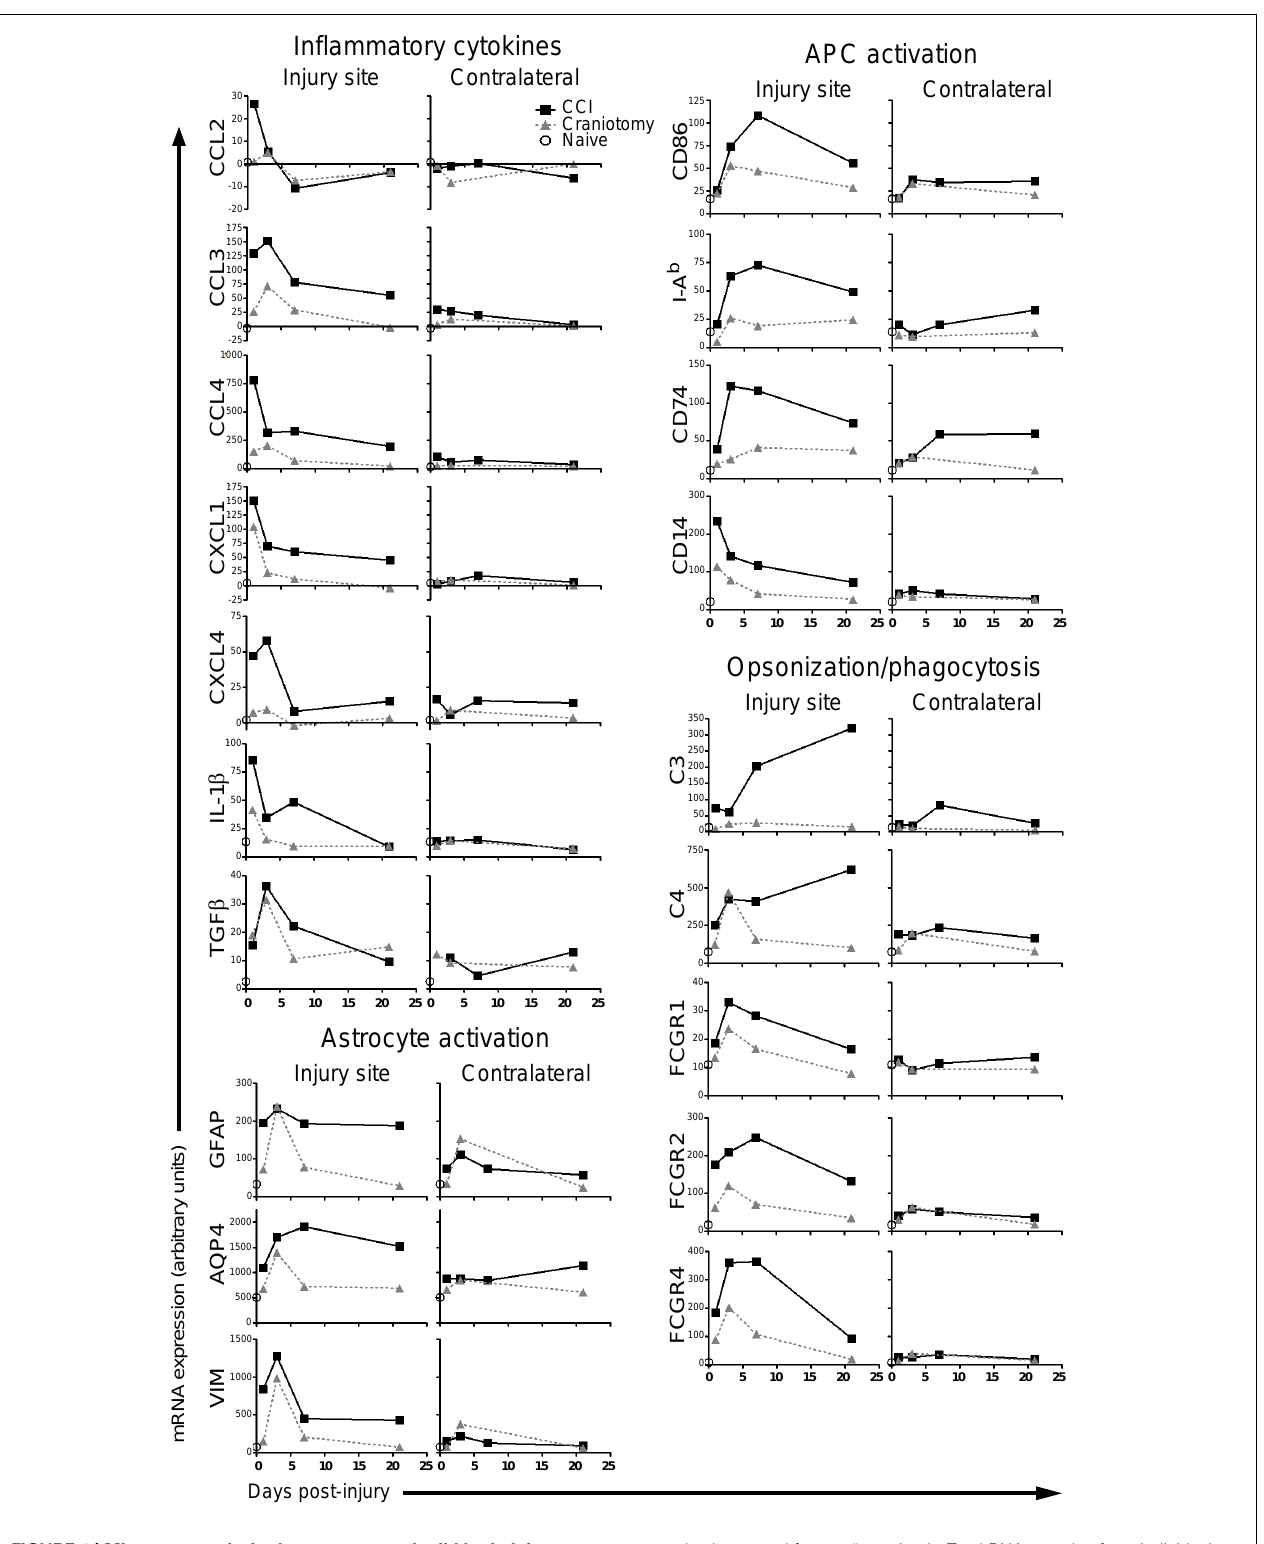
FIGURE 4 | Microarray analysis shows severe and mild brain injury induce expression of multiple inflammation-related transcripts with similar kinetics. Injury site and contralateral site biopsies were harvested from CCI and craniotomy mice at the indicated times post-injury. Brain tissue